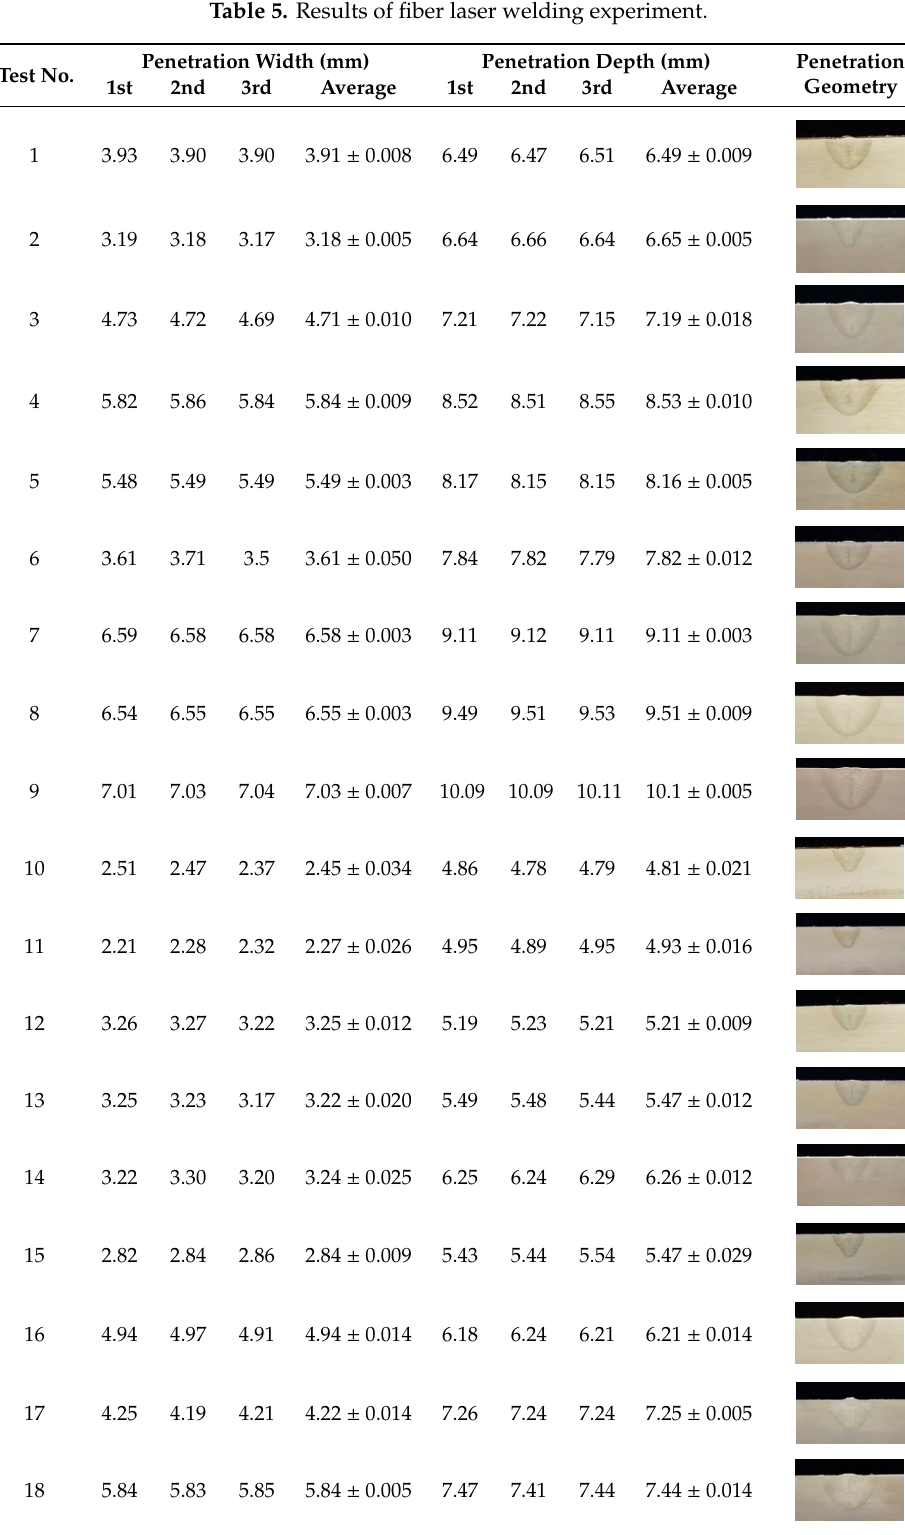
Table 5. Results of fiber laser welding experiment. Test No.